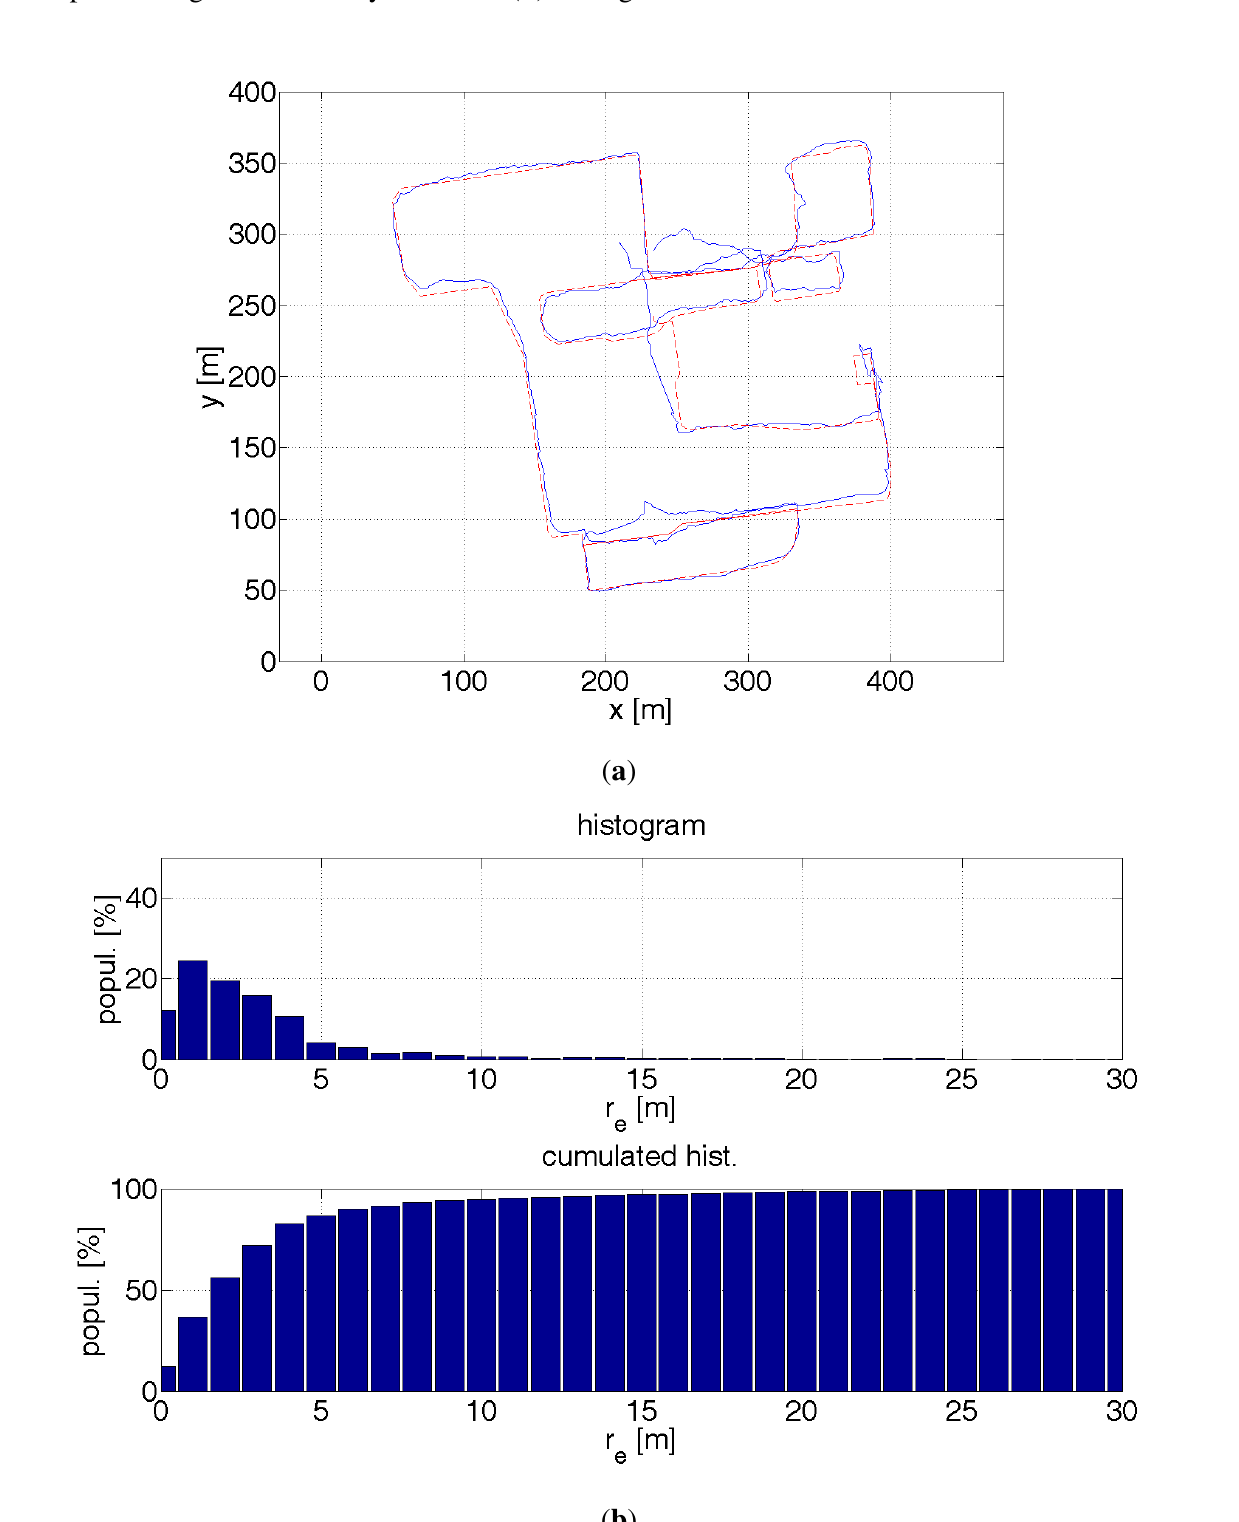
Figure 16. ( a ) Red dashed line—reference path. Blue solid line—estimated path with a help of a GPS receiver. In the presence of buildings, the GPS readouts are ≈ 30 m inaccurate. The errors depends also on the satellites configuration against a building. This can be noticed for coordinates (220 m , 80 m) . The same place was revisited after a couple of minutes and the positioning error was very different. ( b ) Histograms of distance